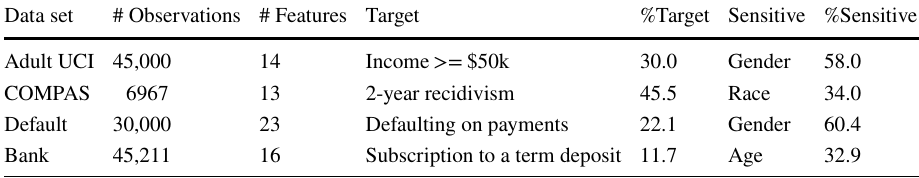
Table 2 Data sets used for the